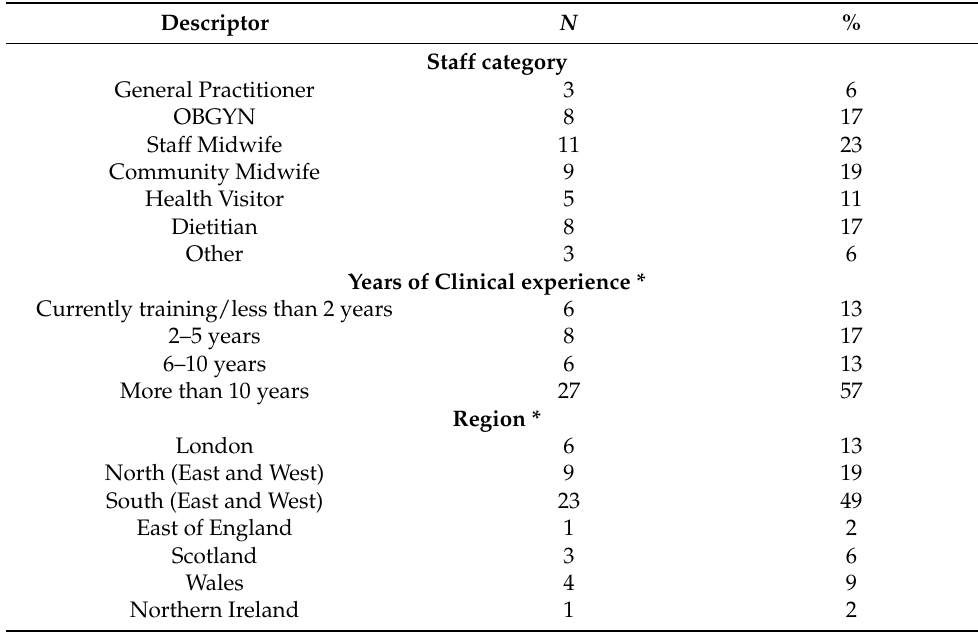
Table 2. Key characteristics of